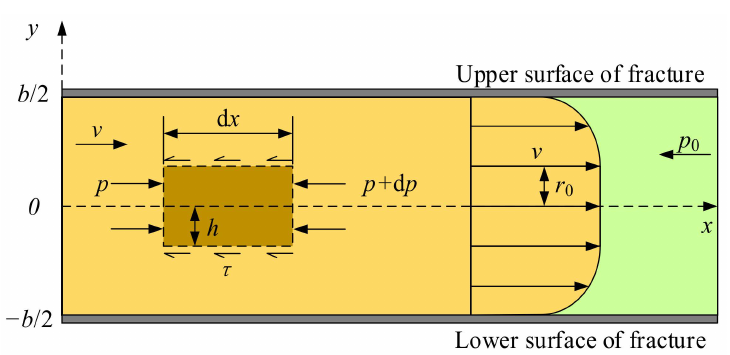
Figure 2. Force analysis of slurry motion